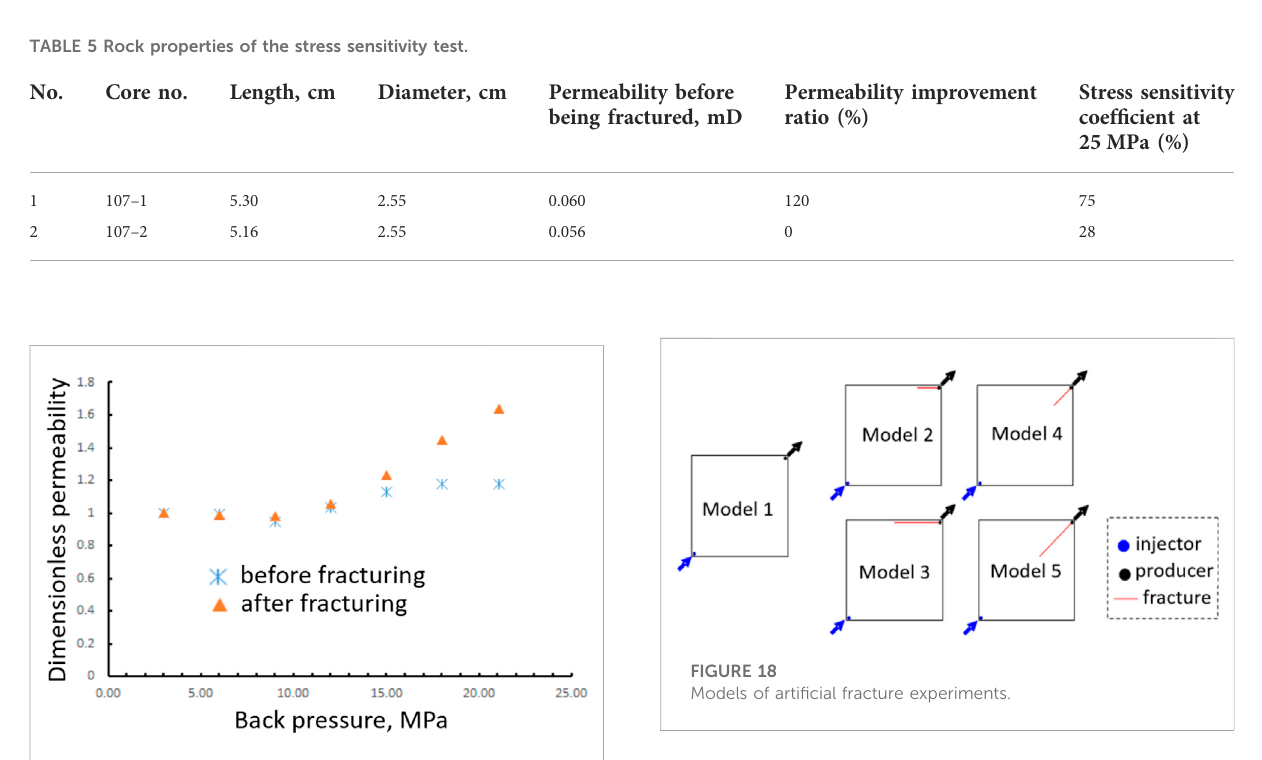
FIGURE 17 Rock stress sensitivity test curve.